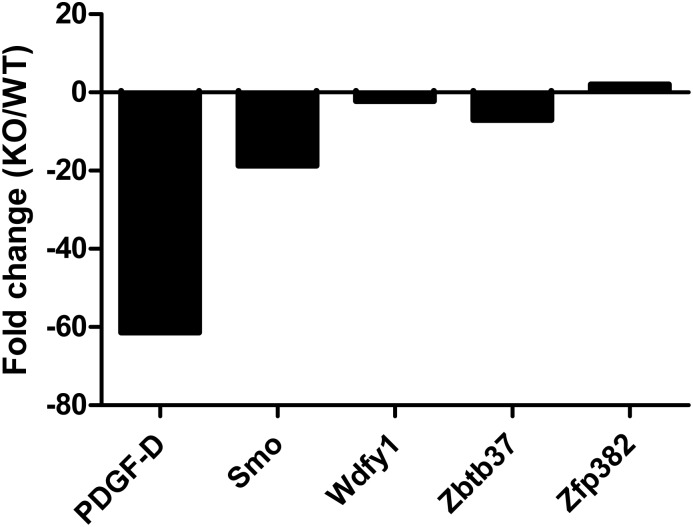
LT-HSCs from AhR-KO mice display alterations in gene expression: LT-HSCs from aged AhR-KO and WT mice were sorted and analyzed for changes in gene expression using qPCR.Genes analyzed were chosen based on their differential expression being dependent on aging as well as lack of AhR expression. The most significant alterations observed were in expression of PDGF-D, Smo, Wdfy1, Zbtb37 and Zfp382. N = 4 each group. A fold change of at least 1.5 was considered significant. Data are fold change values in AhR-KO calculated relative to WT using GAPDH for normalization.